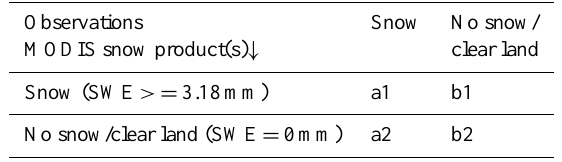
Table 2. Confusion matrices for the MODIS snow products against in situ SWE observations at the Deosai station for the period 2008– 2012.